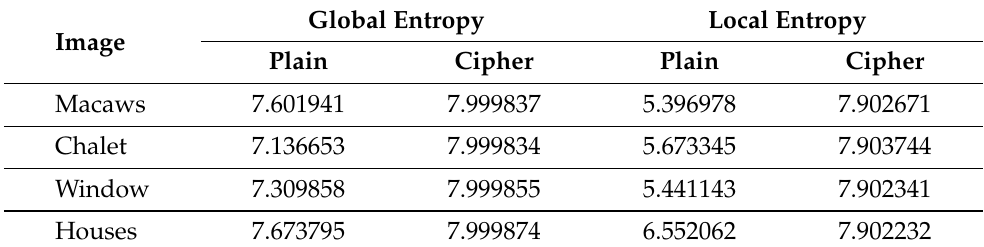
Table 6. Local and global information entropies.